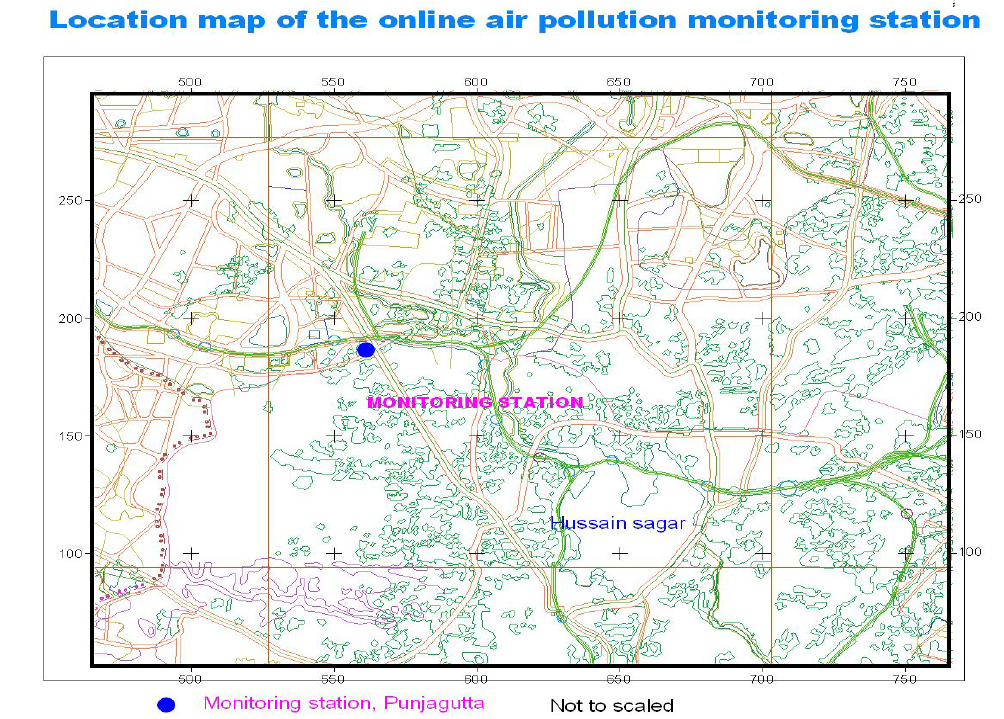
Figure 8 : Location settings of online air pollution monitoring station, Punjagutta